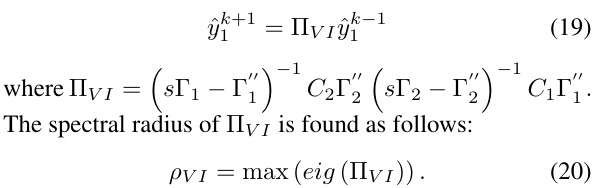
Figure 1: VI-TCCs.